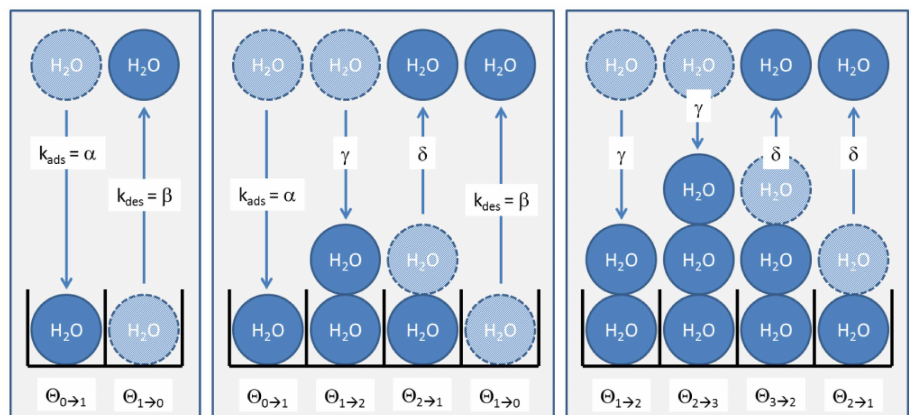
Figure A1. Formation of multi-layer BET adsorbates on a sensor surface. The three boxes indicate adsorption-/desorption processes occurring with a bare substrate, with a substrate covered with one monolayer and with two monolayers of H